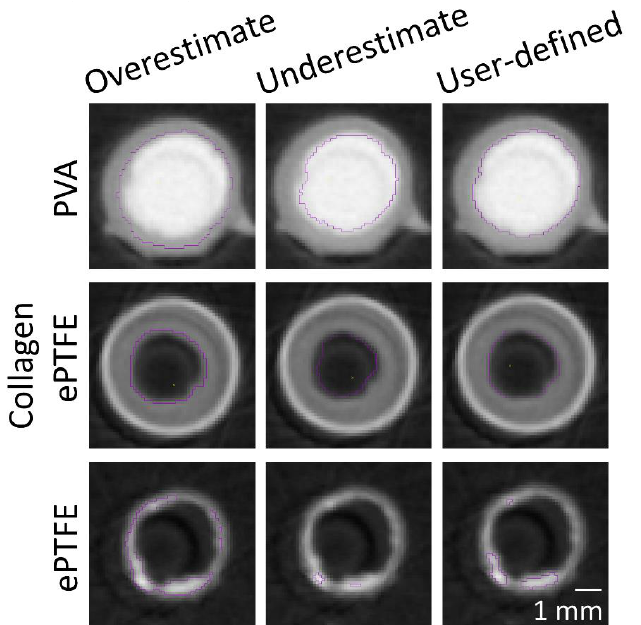
Figure 2. Cross-sectional images of 4mm inner diameter biomaterial graft samples with the luminal area highlighted by the user-selected masking range (purple line). These calibrations were used as a guideline for users to select regions of interest (ROIs) in Amira, which were combined to generate the final surface. Scale bar = 1 mm for all images.